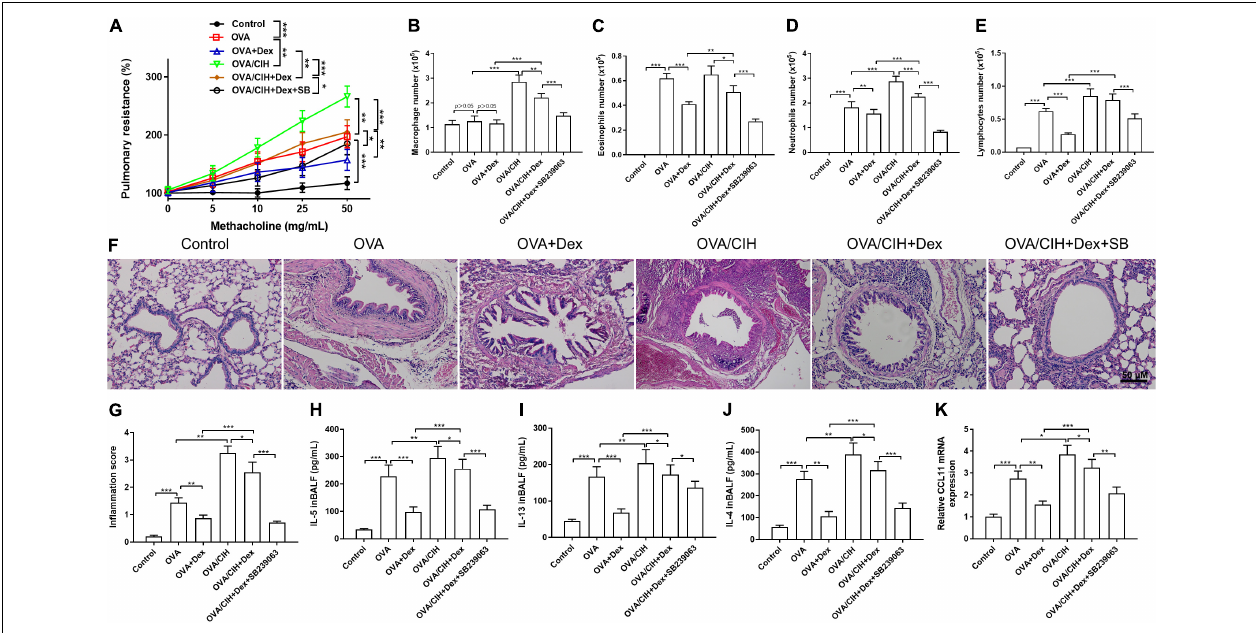
FIGURE 2 | Effects of dexamethasone (Dex) and the p38 MAPK inhibitor, SB239063, on the allergic asthma model with (chronic intermittent hypoxia) CIH exposure. (A) Airway hyperreactivity (AHR) was measured using an invasive pulmonary device for mice. (B) Macrophage cell count, (C) eosinophil cell count, (D) neutrophil cell count, and (E) lymphocyte cell count in bronchoalveolar lavage fluid (BALF). (F,G) Typical hematoxylin and eosin (H&E) staining images of the lung with quantification. (H) IL-4, (I) IL-5, and (J) IL-13 levels in BALF were detected by enzyme-linked immunosorbent assay (ELISA). (K) The level of CCL11 mRNA expression in the lungs as determined by Real-Time Quantitative Reverse Transcription-PCR (qRT-PCR). Data are shown as the mean ± SEM ( n = 6; * p < 0.05; ** p < 0.01; *** p <